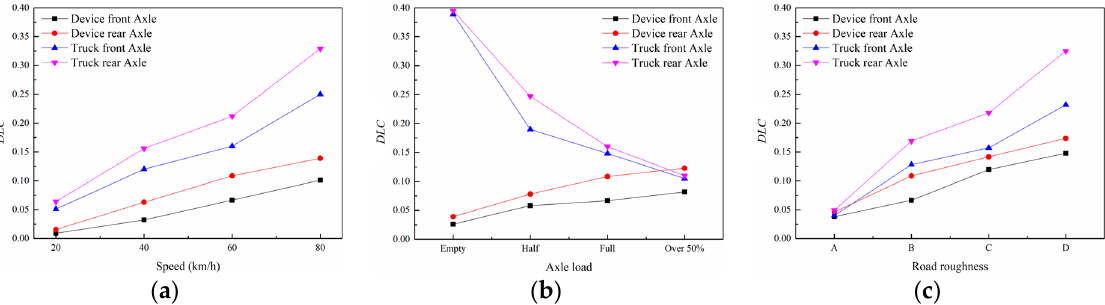
Figure 21. Comparison of DLC between device simulation data and truck measured data. ( a ) Speed. ( b ) Axle load. ( c ) Road roughness. ( b ) Axle load. ( c ) Road